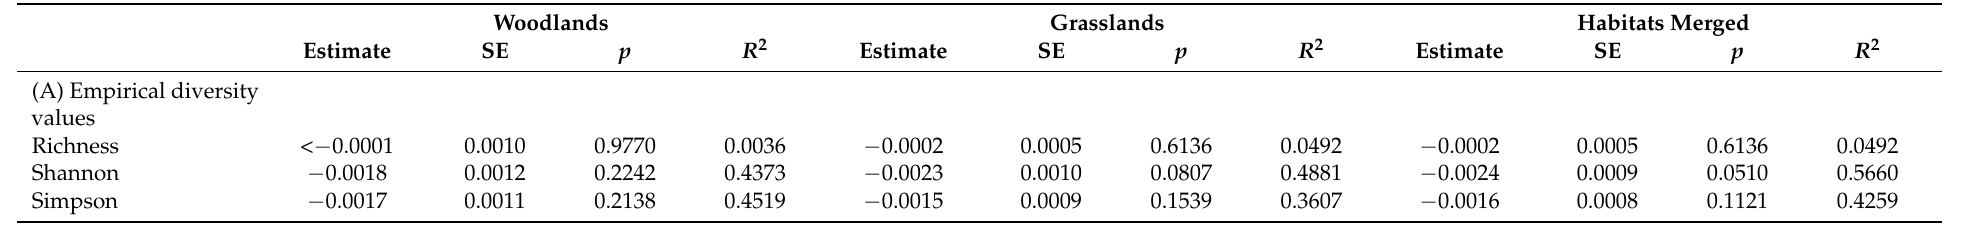
Table 4. Results of generalized linear models for the relationships between diversity ( A – C ) and abundance ( D ) of scarabaeid dung beetles and altitude along an elevational gradient in central Italy. Diversity (expressed as species richness, Shannon diversity and Simpson diversity) was calculated using empirical ( A ), rarefied/interpolated ( B ), and asymptotic ( C )